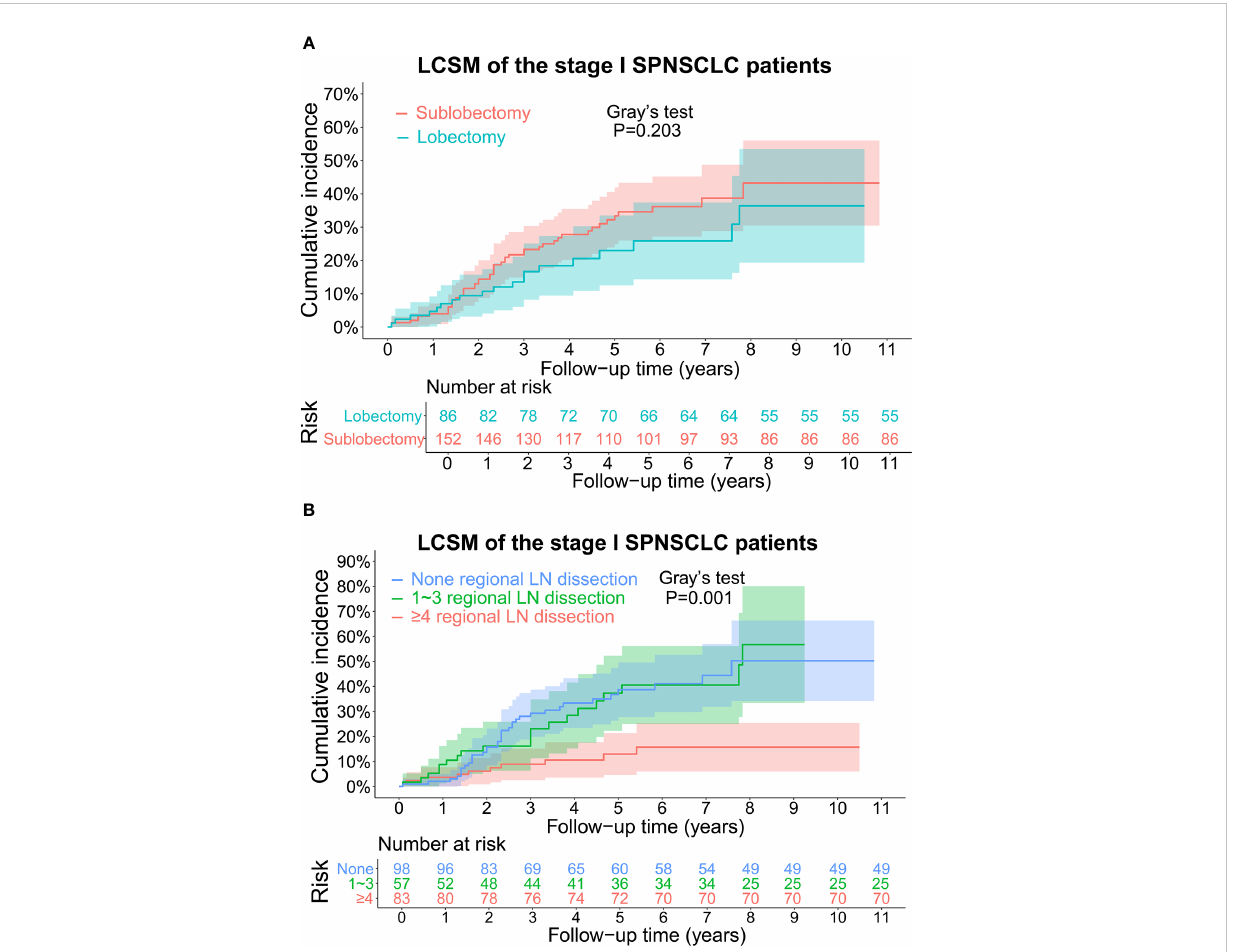
FIGURE 3 (A) CIF curves for estimating the LCSM in the whole stage I SP cohort before propensity score matching, and the differences in CIF between the patients undergoing sublobectomy and patients undergoing lobectomy. The number of patients at risk was listed under the fi gure, and the shaded bands represented the 95% con fi dence intervals. P-value of difference in CIF was determined based on Gray ’ s test. (B) CIF curves for estimating the LCSM in the whole stage I SP cohort before propensity score matching, and the differences in CIF among the patients without regional LN dissection, patients undergoing 1~3 regional LN dissection and patients undergoing ≥ 4 regional LN dissection. The number of patients at risk was listed under the fi gure, and the shaded bands represented the 95% con fi dence intervals. P-value of difference in CIF was determined based on Gray ’ s test. CIF, cumulative incidence function; LCSM, lung cancer-speci fi c morality; LN, lymph node; SP, second primary non-small cell lung